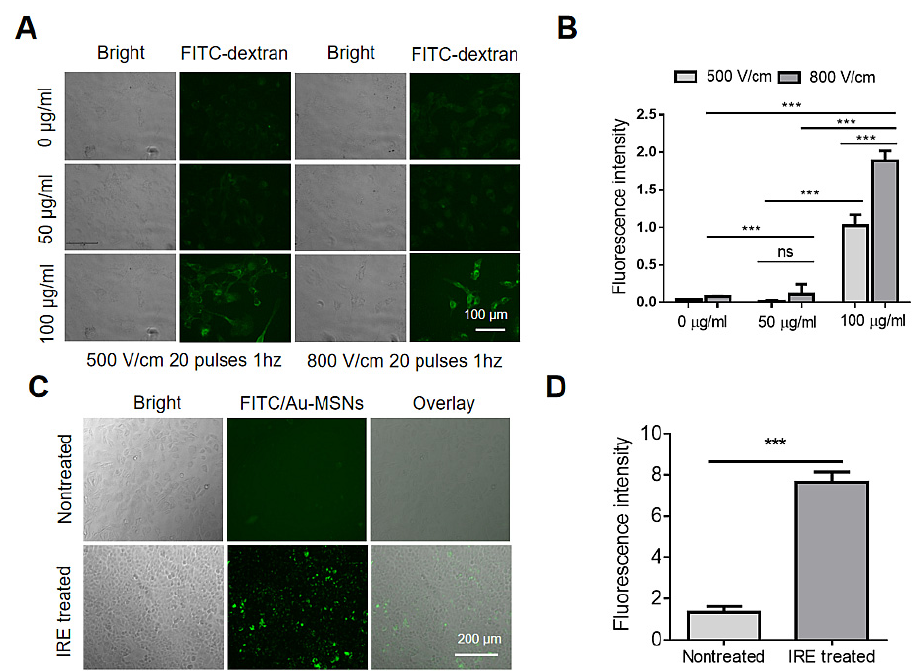
Figure 2. The enhanced cellular permeability of EMT-6 cells under IRE treatment with Au-MSNs. ( A ) Fluorescence microscopic images of EMT-6 cells show that IRE-treatment (500 V/cm and 800 V/cm) with Au-MSNs (50 µ g/mL and 100 µ g/mL) increased cell membrane permeability of EMT-6 cells. Membrane permeability was observed using fluorescein isothiocyanate-dextran (FITC- dextran). ( B ) Analysis of fluorescence intensity. Co-treatment of EMT-6 cells with IRE (800 V/cm) and Au-MSNs (100 µ g/mL) increased the cellular permeation of FITC-dextran by 25-fold. ( C ) The en- hanced cellular uptake of FITC/Au-MSNs under IRE treatment (800 V/cm). Fluorescence microscopic images suggest IRE treatment of EMT-6 cells dramatically increased the uptake of FITC/Au-MSNs. ( D ) Analysis of fluorescence intensity of EMT-6 cells. Data proved IRE treatment of EMT-6 cells increased the uptake of FITC/Au-MSNs by 7-fold. (Data are provided as means ± standard deviation. Data were tested for significance using Student’s t -test and a two-way ANOVA. Significant differences are indicated by *** p < 0.01. n= 3–5).